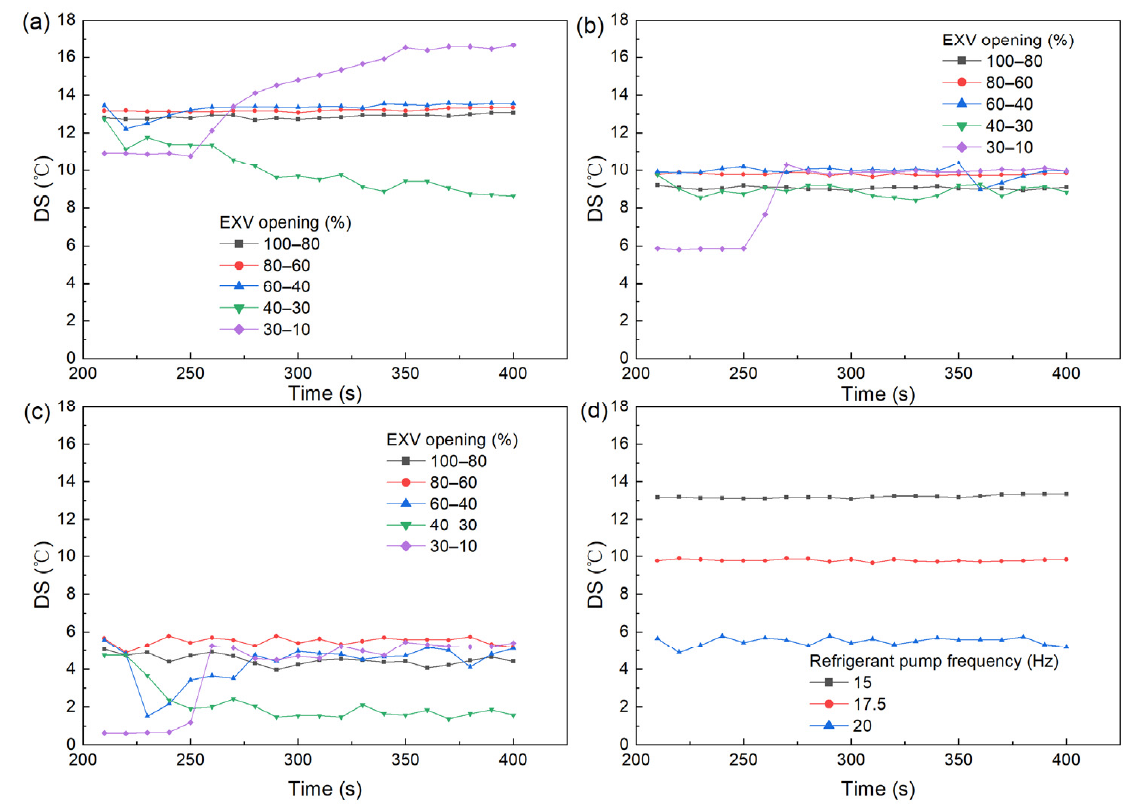
Figure 3. Change curves of DS when the refrigerant pump opening is 40% ( a ) the refrigerant pump frequency is 15 Hz, and the EXV1 opening is 100%–10%; ( b ) the refrigerant pump frequency is 17.5 Hz, and the EXV1 opening is 100%–10%; ( c ) the refrigerant pump frequency is 20 Hz, and the EXV1 opening is 100%–10%; ( d ) the EXV1 opening is 80%–60%, and the refrigerant pump frequency is 15 Hz, 17.5 Hz, and 20 Hz,